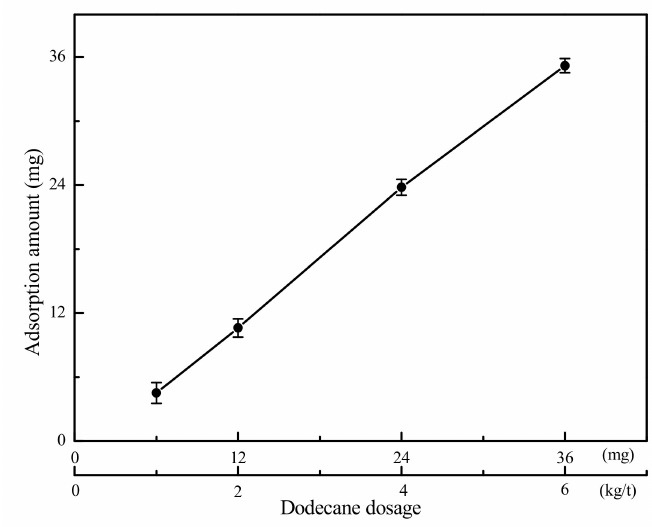
Figure 4. Adsorption results of gaseous dodecane on LRC surface (The data points represent the mean values (n = 3) ± standard deviation.).